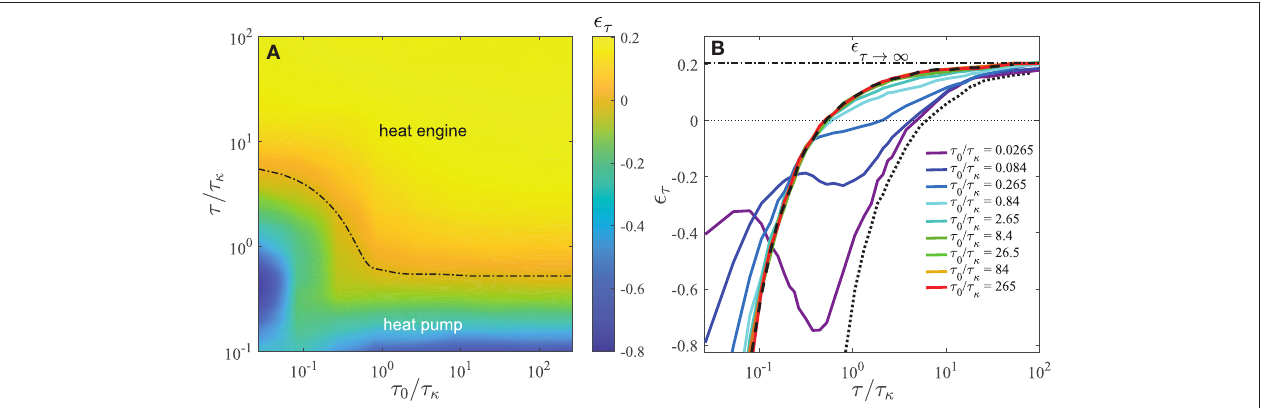
FIGURE 5 | (A) 2D color map representation of the efficiency of the colloidal Stirling engine, ǫ τ , as a function of the fluid relaxation time, τ 0 , and the duration of a Stirling cycle, τ . The dotted-dashed line corresponds to the stall time τ ∗ , which separates the values of the parameters τ 0 and τ for which the system operates as a heat engine ( ǫ τ > 0) from those for which it behaves as a heat pump ( ǫ τ < 0). (B) Examples of efficiency curves as function of the duration of a Stirling cycle, τ , for some particular values of the fluid relaxation time (solid lines). The dotted and dashed lines represent the efficiency curves of a Brownian Stirling engine in Newtonian fluids η 0 and η η with constant viscosity η , respectively. The dotted-dashed line depicts the quasi-static value of the Stirling efficiency, ǫ τ = = ∞